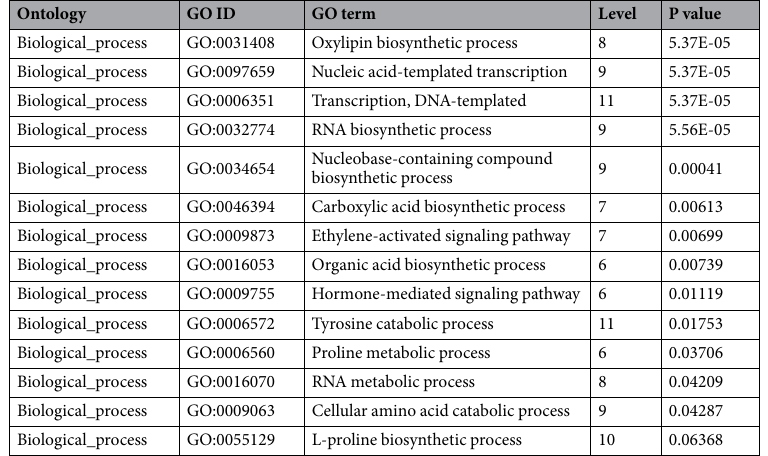
Table 1. Enriched GO terms in the up-regulated common genes between drought and heat stress condition, using the threshold of GO term level ≥ 6.